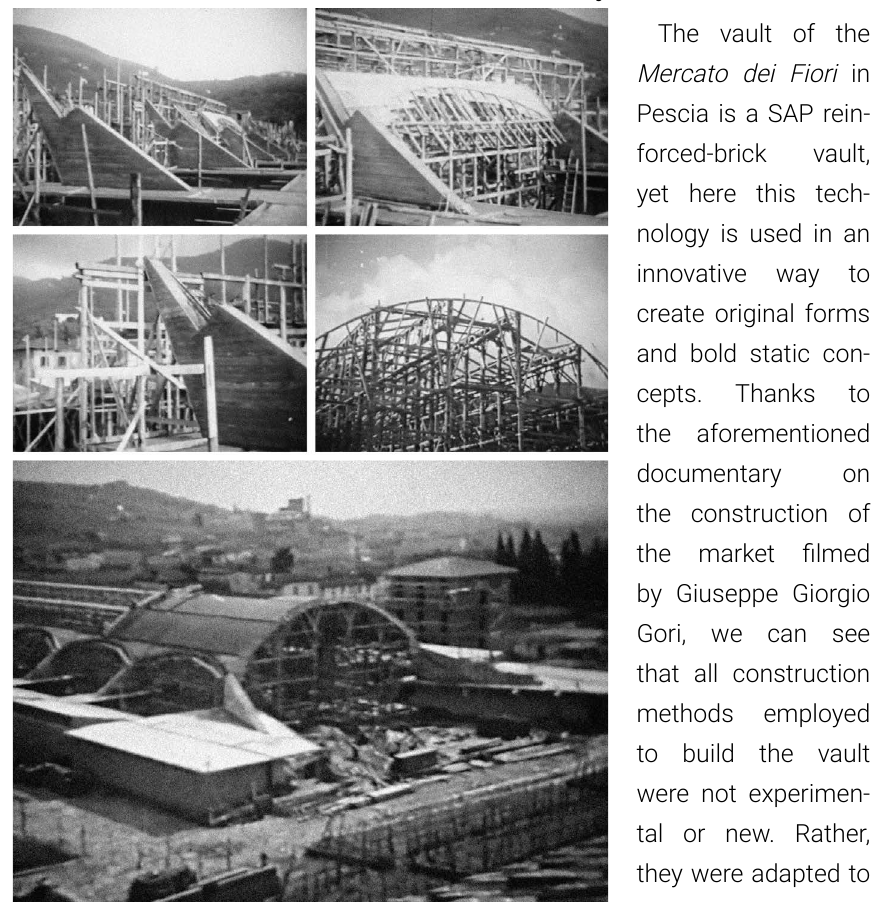
Fig. 5 Advertising of the SAP self-sup- porting cement-block floor slabs and vaults, produced by Fornaci F.lli Rizzi, Donelli, Breviglieri (RDB),